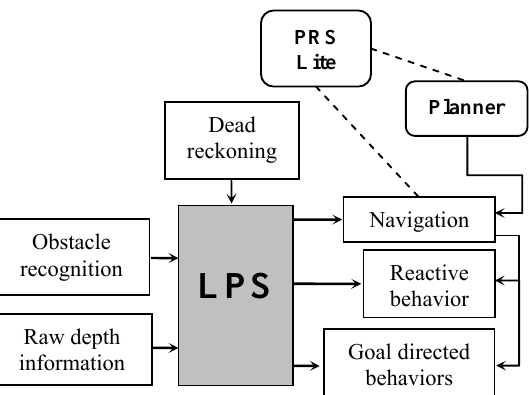
Fig. 11. Saphira system architecture. Perceptual bocks are on the left and action blocks are on the right. Control is coordinated by